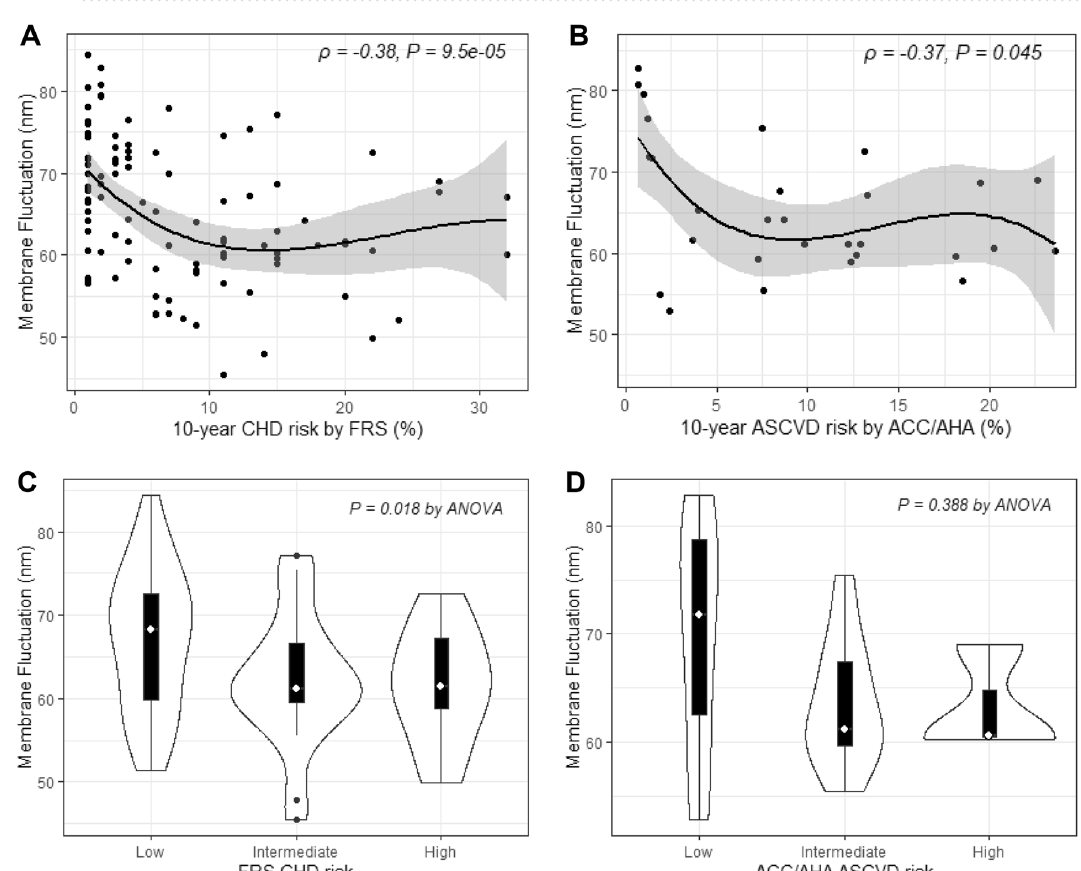
Figure 4. Correlation between red blood cell-membrane fluctuations (RBC-MFs) and 10-year cardiovascular disease (CVD) risks. ( A ) Ten-year CHD risk by FRS, ( B ) Ten-year ASCVD risks by ACC/AHA guidelines, ( C ) Ten-year CHD risk with risk criteria as follows: low (< 10%), intermediate (10–19%), and high (≥ 20%), ( D ) 10-year ASCVD risk with risk criteria as follows: low (< 5%), borderline (5–7.4%), intermediate (7.5–19.9%), and high (≥ 20%). CHD, coronary heart disease; FRS, Framingham risk score; ASCVD, atherosclerotic CVD; ACC, American College of Cardiology; AHA, American Heart